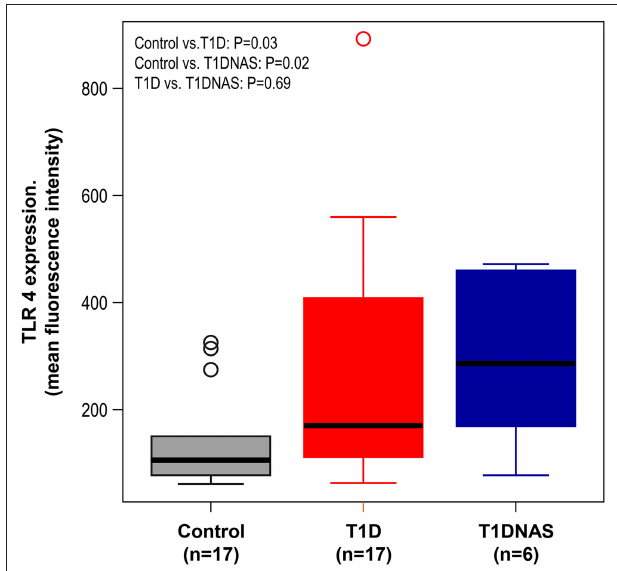
FIGURE 1 | Expression level of TLR4 in monocytes by mean fluorescence intensity (MFI) in control subjects ( N = 17), type 1 diabetes patients from multiplex families (T1D) ( N = 17) and their non-affected siblings (T1DNAS) ( N = 6). Control vs.T1D: P = 0.03; Control vs. T1DNAS: P = 0.02; T1D vs. T1DNAS: P =